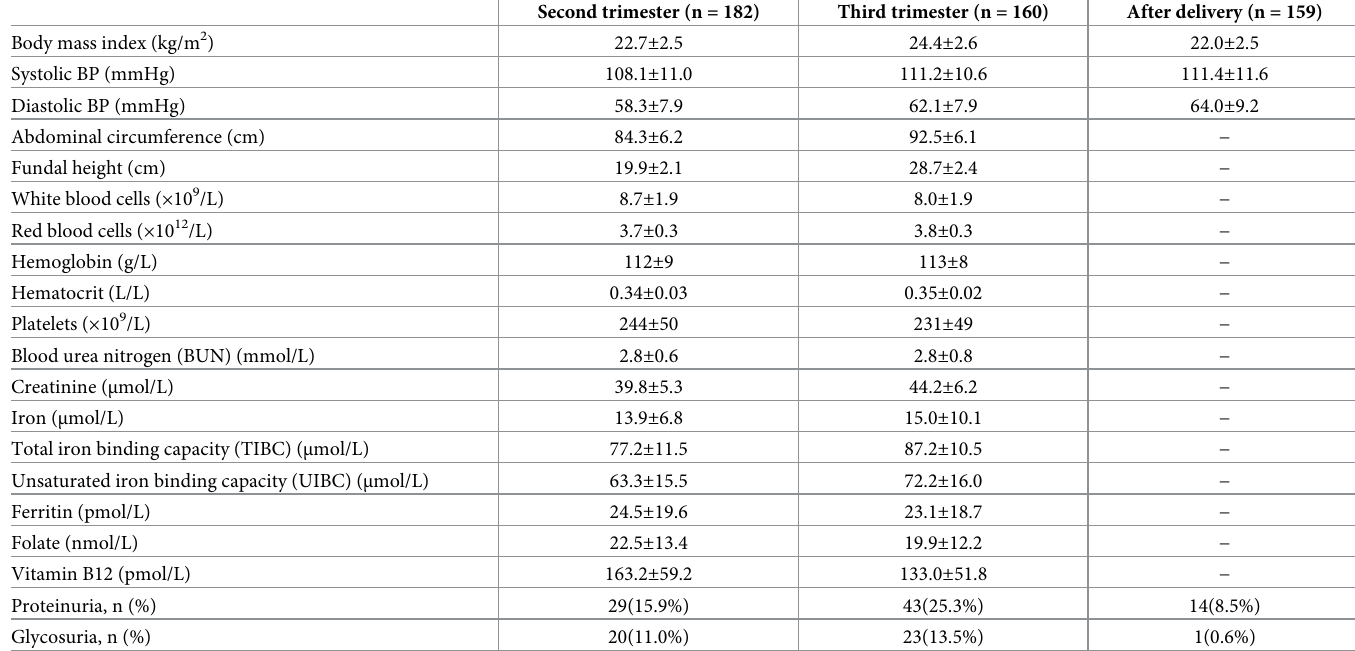
Table 2. Clinical features at each study